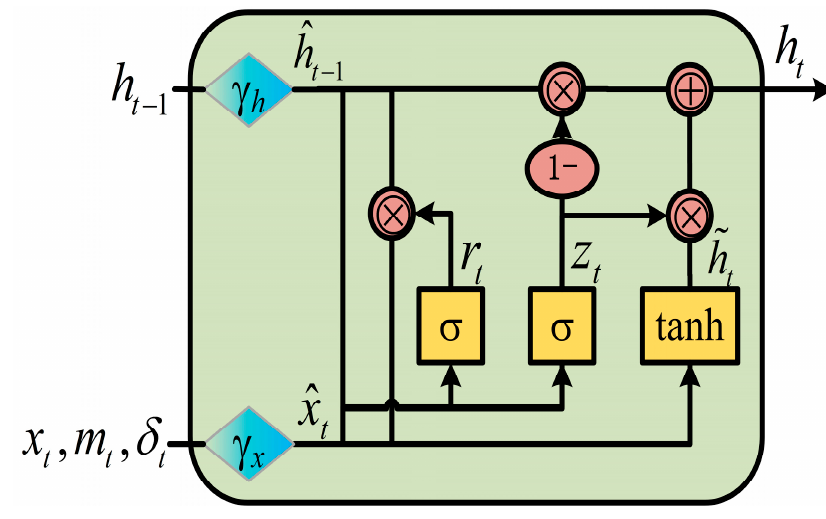
Figure 3. Schematic of the GRUD.